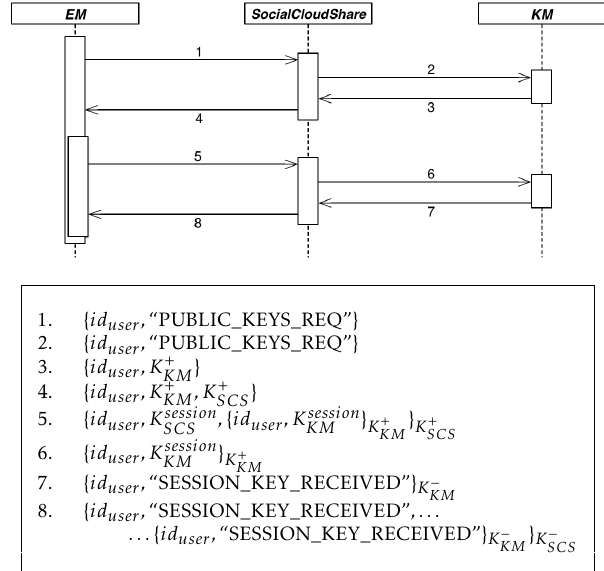
Figure 8. Login phase: messages